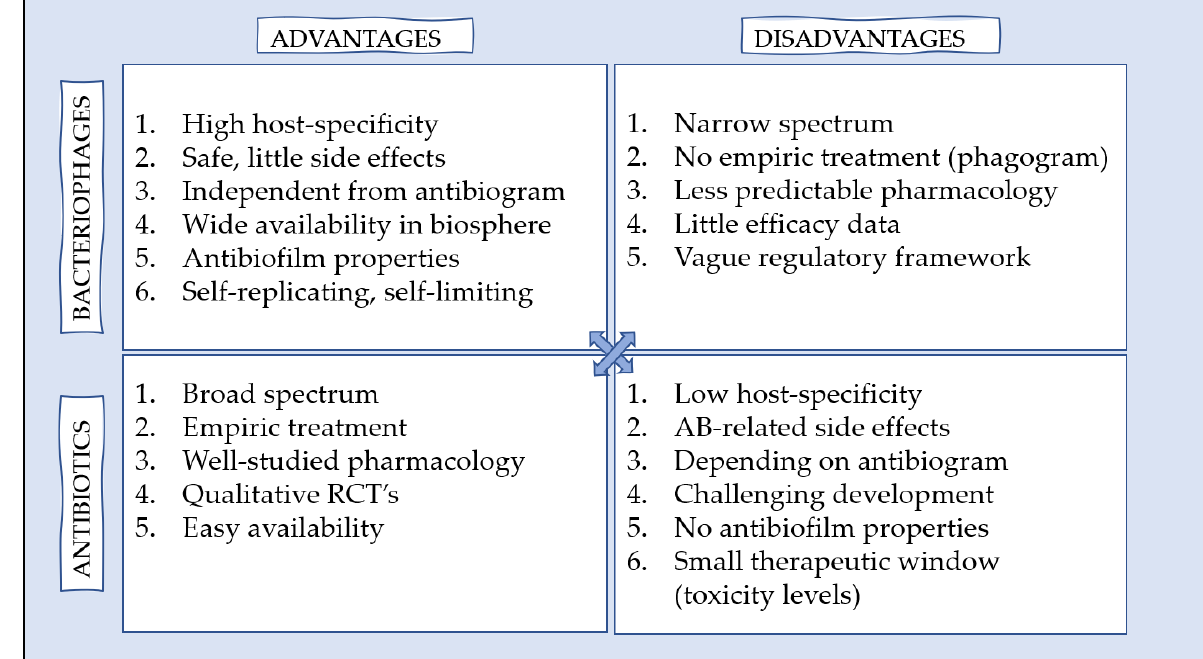
Figure 2. Advantages and disadvantages of bacteriophages and